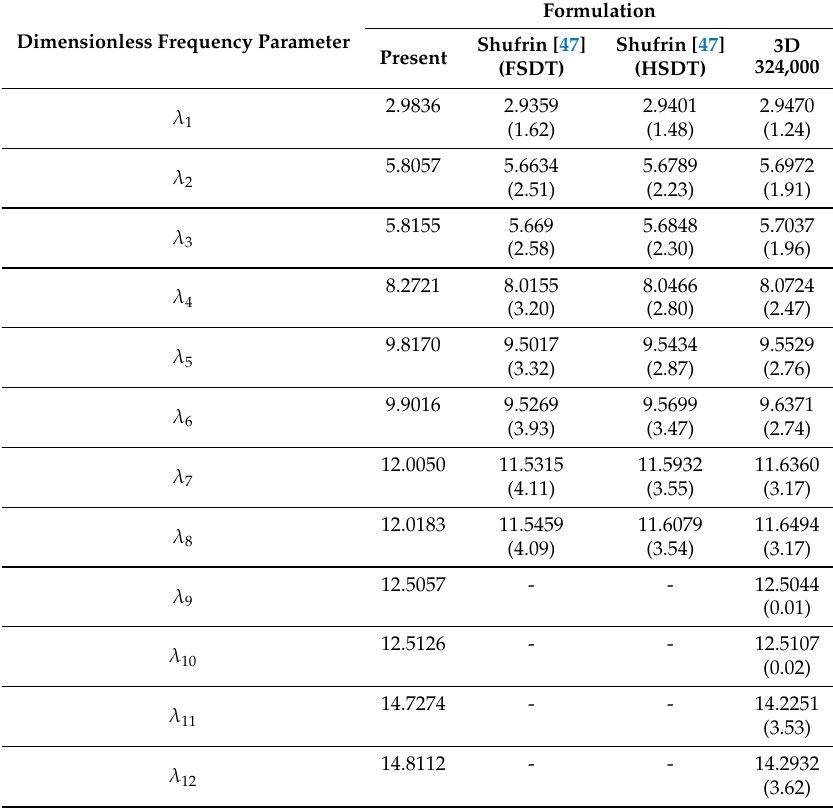
Table 11. Comparison of results for a square plate of ratio b / h 0 = 10 and CCCC boundary